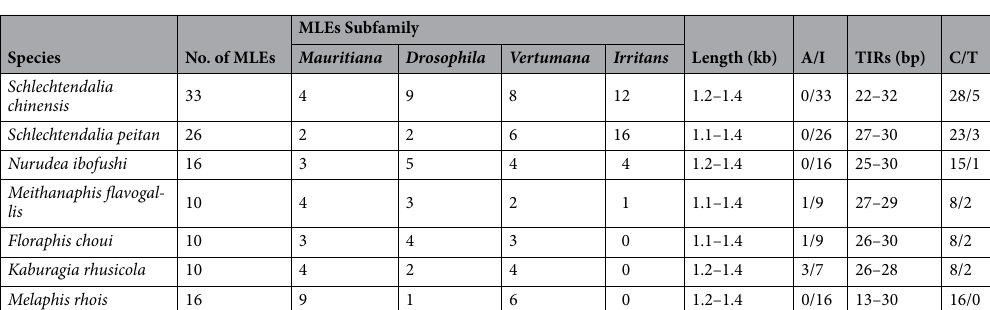
Table 1. The total number of MLEs in all the seven Rhus gall aphid species, number of MLEs detected in each species and its classifications into subfamilies of MLEs are shown. A/I potentially active/inactive, C/T complete copies/truncated